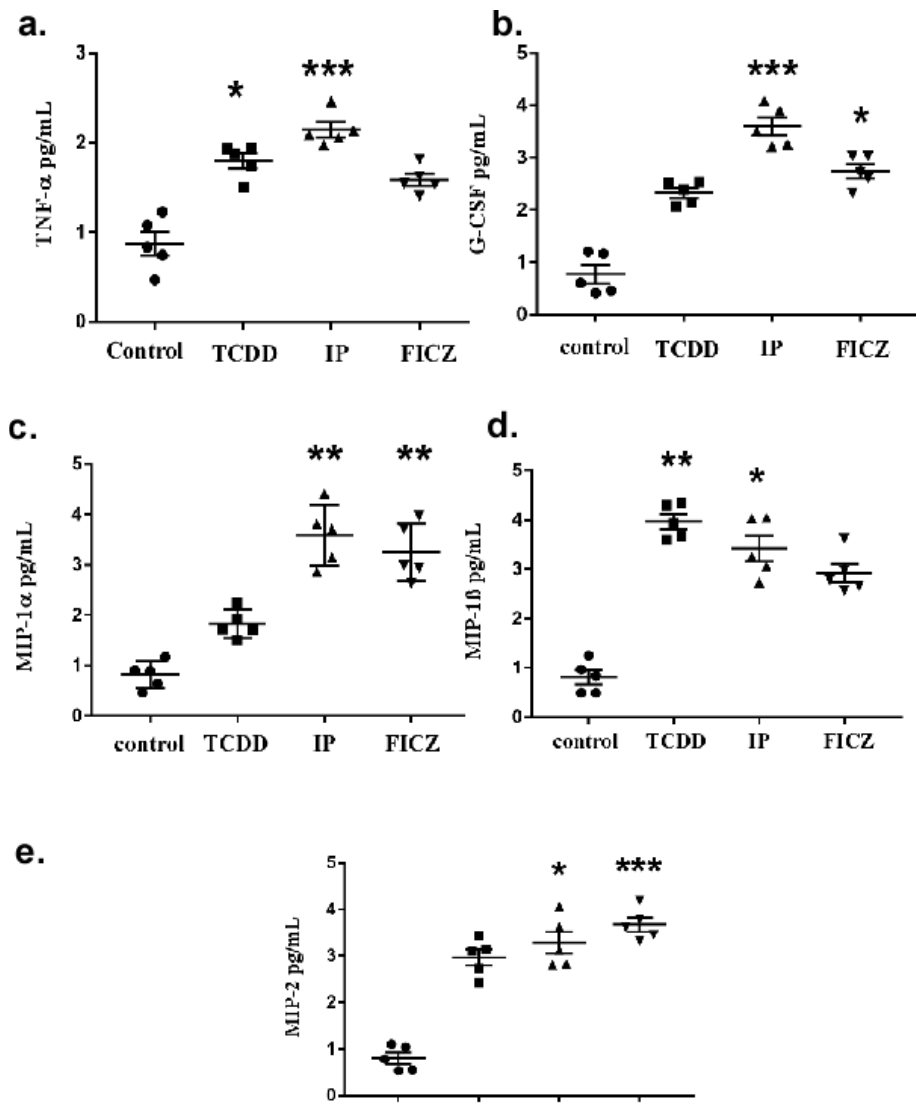
Figure 2. Activation of AhR in macrophages induces inflammatory markers and fibrosis associated cytokines. In a serum-free DMEM medium, RAW 264.7 cells were cultured for 24 h with TCDD (10 −8 M), IP (10 −7 M), and FICZ (10 −7 M). An increase in cytokine levels is shown as folds of increase compared to the control culture. ( a ) TNF- α expression, ( b ) G-CSF expression, ( c ) MIP-1 α expression ( d ) MIP-1 β expression, ( e ) MIP-2expression Three independent experimental means ± SEM are represented in the graph. Unstimulated comparisons to control cultures were depicted by asterisks, * p < 0.05, ** p < 0.01 and *** p < 0.001 by one-way ANOVA analysis.